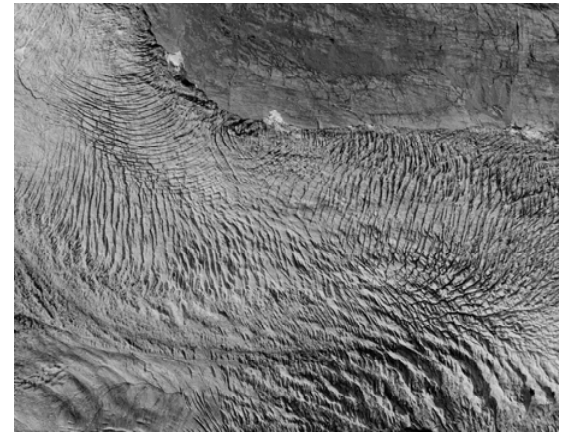
Figure 3. A section of the aerial photographic image (1,233 m × 1,233 m) over part of the Nigardsbreen taken on 19 August 2001, North to the